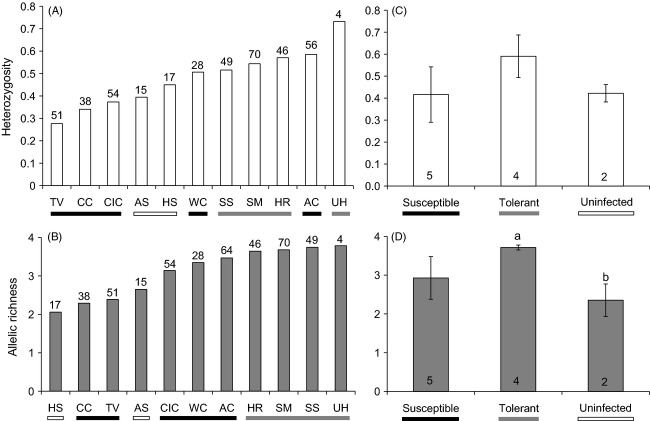
Lithobates yavapaiensis disease dynamics and population genetics. Mean (A) heterozygosity and (B) allelic richness for 512 individuals from 11 populations genotyped at 14 microsatellite loci are shown in ascending order with population disease status identified as susceptible (black symbols; populations with observed mortality), tolerant (gray symbols; no observed mortality), or uninfected [white symbols; Batrachochytrium dendrobatidis (Bd) not detected]. Sample sizes are shown above each bar. Mean (C) heterozygosity and (D) allelic richness across susceptible, tolerant, and uninfected population categories. Sample sizes are shown inside of each bar (N = number of populations). Significant differences (Student's t-test, P < 0.05) in mean values across disease categories are denoted by different lowercase letters. Population abbreviations follow Fig.1. MR is excluded due to variable environmental conditions.